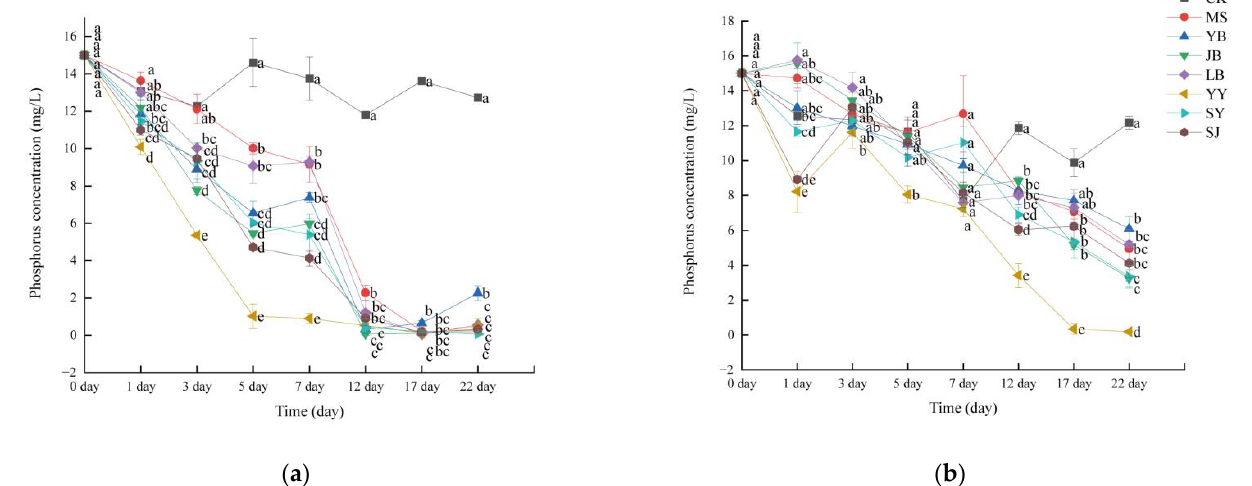
Figure 4. Concentrations of TP in the beakers with different O. javanica cultivars at different temperatures. Different letters indicate the significance of the difference of the concentration on the same day. ( a ) Concentrations of TP at room temperature. ( b ) Concentrations of TP under cold stress. MS: